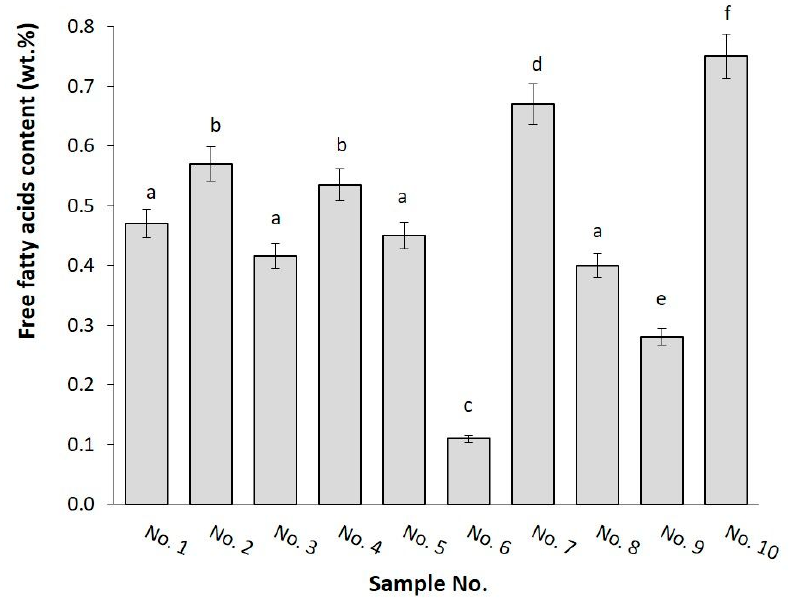
Figure 3. Free fatty acids (wt.%) in butters, spreadable fats, and shortenings (bar chart with 5% error bars). Different superscript letters above the bars indicate statistically significant differences between the samples ( α ≤ 0.05, Tukey test).